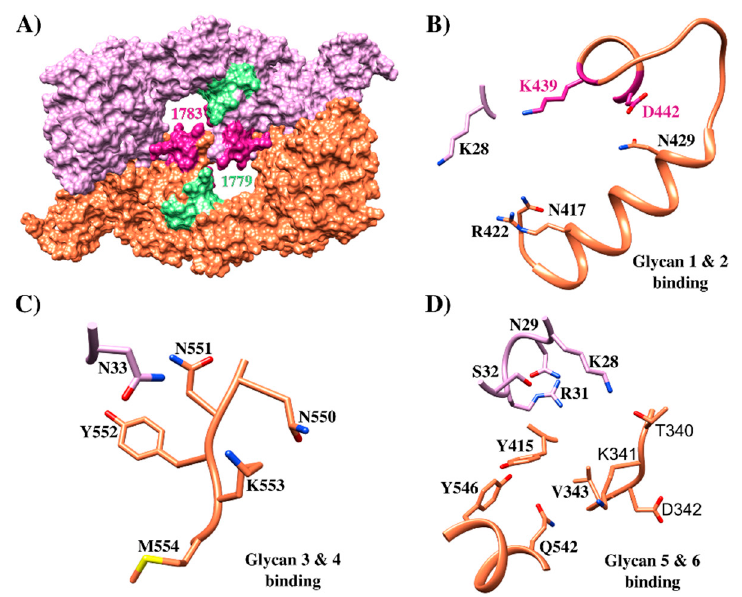
Figure 6. EBA-175 structure and its critical interactions. ( A ) Crystallographic structure of EBA-175 (PDB 1ZRL) [95] highlighting HABPs 1779 (green) and 1783 (pink); ( B ) glycan 1 and 2 binding sites to EBA-175, HABP 1783 439 K and 442 D residues contacting these glycans are highlighted in pink (PDB 1ZRO) [95]; ( C ) glycan 3 and 4 EBA-175 binding sites (PDB 1ZRO) [95] ( D ) glycan 5 and 6 EBA-175 binding (PDB 1ZRO) [95].